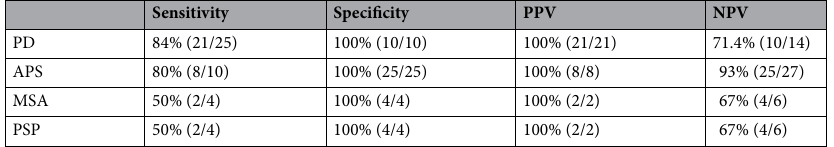
Table 2. Discriminative measures for the Stockholm cohort. APS atypical parkinsonian syndrome, MSA multiple system atrophy, NPV negative predictive value, PD Parkinson’s disease, PPV positive predictive value, PSP progressive supranuclear